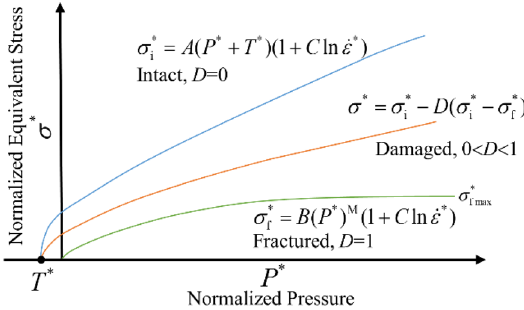
Figure 6. Strength model of the JH-2 constitutive